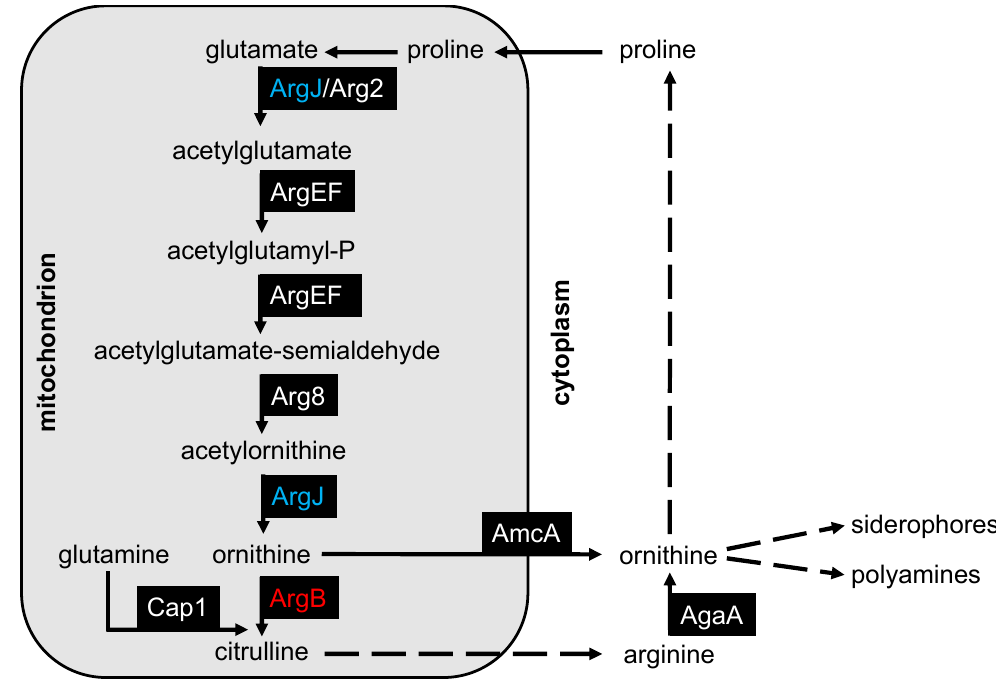
Figure 1. Schematic illustration of arginine/ornithine biosynthesis in Aspergillus fumigatus . Starting with glutamate, ornithine is synthesized in the mitochondrion in five enzymatic steps, and either directly transported to the cytoplasm via the ornithine transporter AmcA or converted into citrulline before being transported to the cytoplasm. Citrulline is converted into arginine and further into ornithine via arginase. Ornithine serves as precursor for extra- and intracellular siderophore production. ArgJ (AFUA_5G08120, in blue), bifunctional acetylglutamate synthase/ornithine acetyltransferase; Arg2 (AFUA_2G11490), acetylglutamate synthase; ArgEF (AFUA_6G02910), bifunctional acetylglutamate kinase and N-acetyl-gamma-glutamyl-phosphate reductase; Arg8 (AFUA_2G12470), acetylornithine aminotransferase; ArgB (AFUA_4G07190; in red), ornithine carbamoyltransferase; AmcA (AFUA_8G02760), mitochondrial ornithine exporter; AgaA (AFUA_3G11430), arginase; Cap1 (AFUA_5G06780), carbamoyl-phosphate synthase. Dashed lines indicate metabolic routes involving more than one enzyme. Refer to Table S1 for details regarding homology of the enzymes.